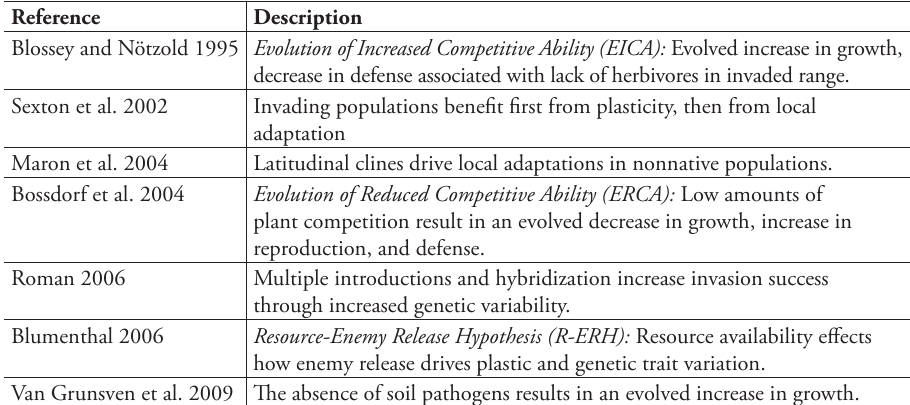
table 1. Published hypotheses related to post-establishment evolution.